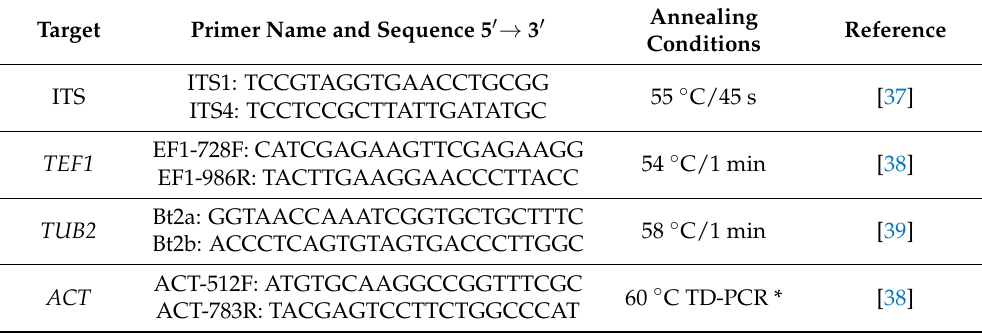
Table 2. Annealing conditions of PCR assays, primers and their references. Target Primer Name and Sequence 5 (cid:48) → 3